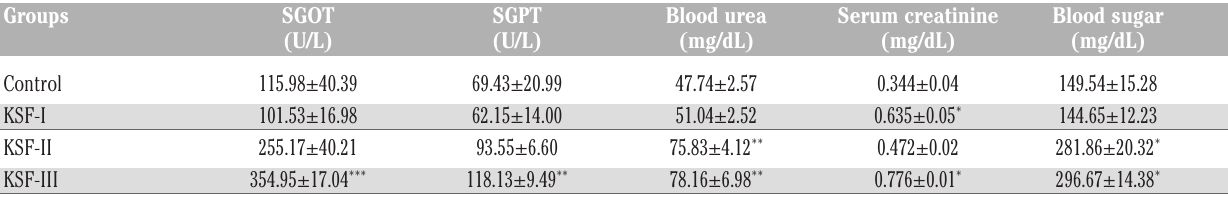
Table 2. Biochemical changes produced by Kushta